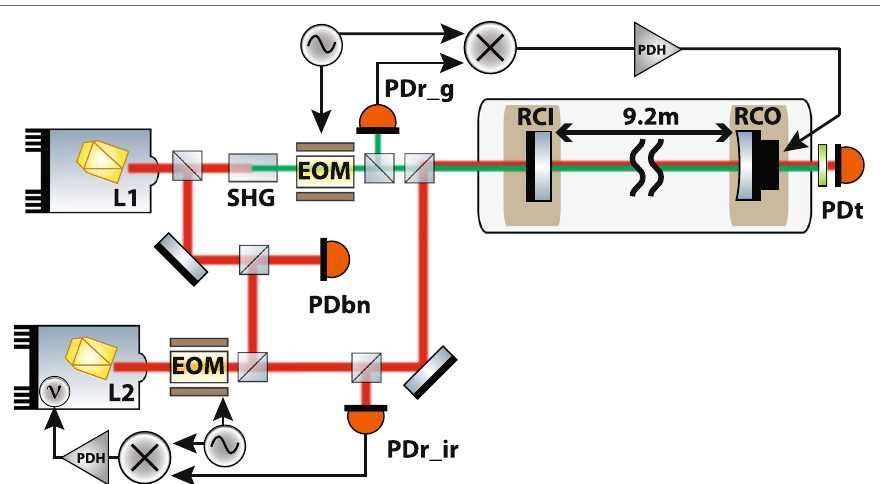
Fig. 1 Experimental setup. LengthcontroloftheRC: The cavity consists of the mirrors RCI and RCO as well as a PDH feedback control loop. A high bandwidth length actuator is attached to RCO. The laser beam from laser L1 is frequency doubled in a temperature controlled SHG. An EOM imprints phase modulation sidebands on the laser beam and the photodetector PDr_g is used to sense the PDH error signal. Laserfrequencyfeedback: For the high finesse cavity operation with 1064nm light the frequency of laser L2 follows the RC. The feedback control loop uses PDr_ir as a sensor and photodetector PDt in transmission of the cavity is used to measure the storage time. Beatnotefrequencymeasurement: The beatnote signal between L1 and L2 is measured with a high bandwidth photodetector